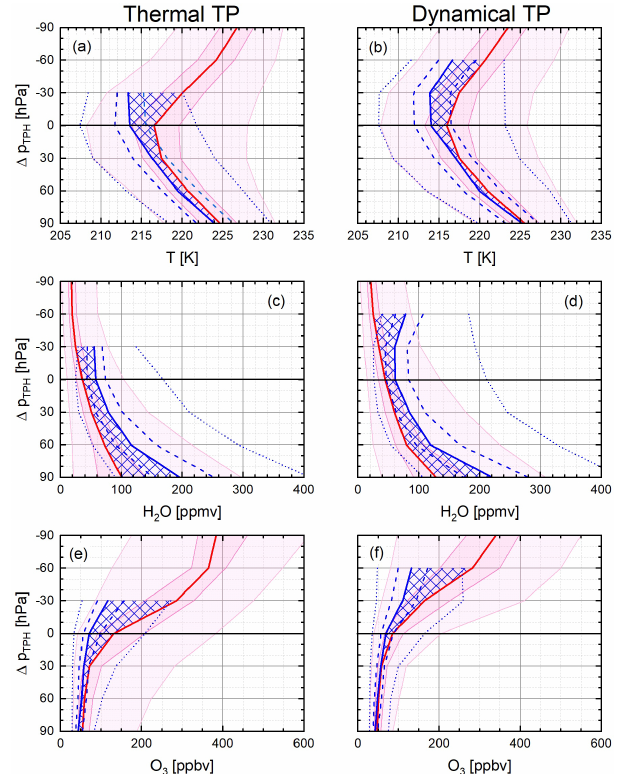
Figure 10. Vertical distribution of temperature, H 2 O VMR and ozone VMR for ISSRs relative to the thermal tropopause height (a, c, e) and 2PVU dynamical tropopause height (b, d, f) . ISSR condi- tions are presented as percentiles (1, 25, 50, 75 and 99) by blue lines and non-ISSR conditions by red-shaded areas. Blue cross-hatched areas highlight the deviation of median values between ISSR and non-ISSR conditions.